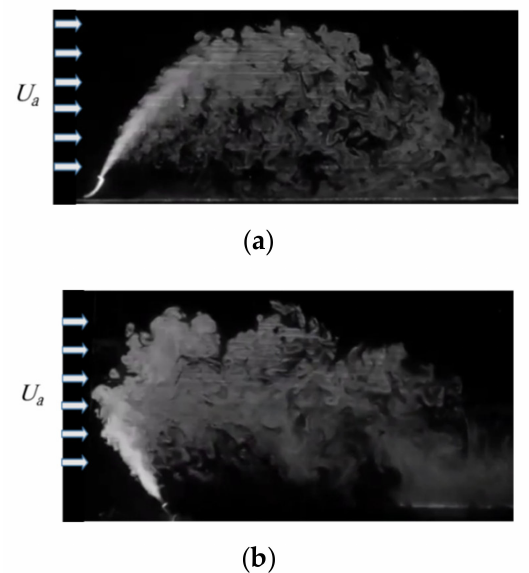
Figure 4. Buoyant jet trajectory behaviors in: ( a ) uniform co-flow receiving environment retrieved from [47], and ( b ) uniform counter-flow receiving environment retrieved from